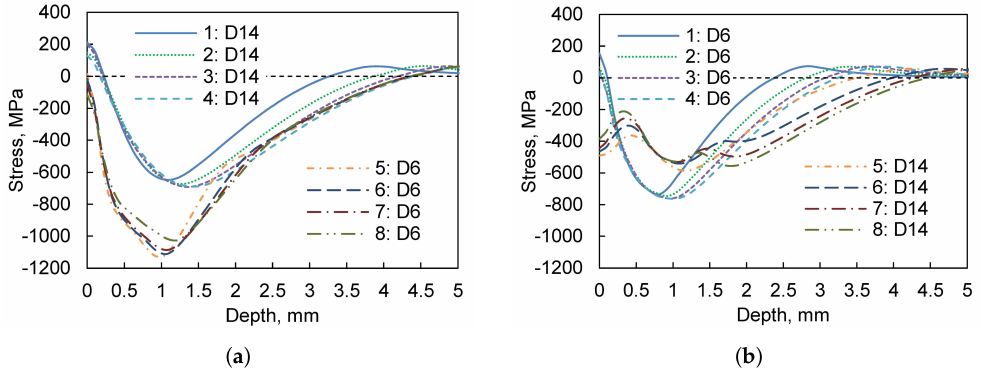
Figure 13. Stress evolution of combined hammering